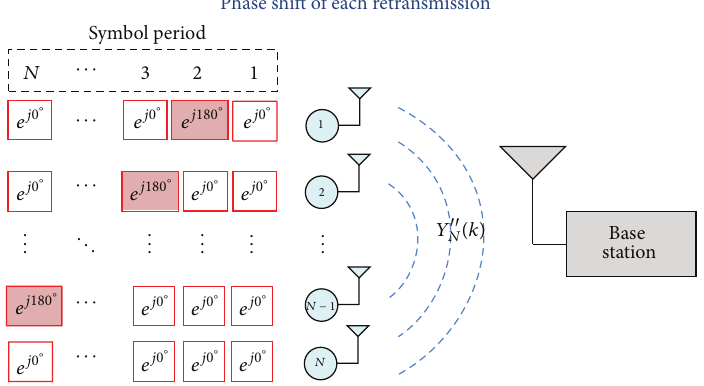
Figure 4: Proposed phase shifting